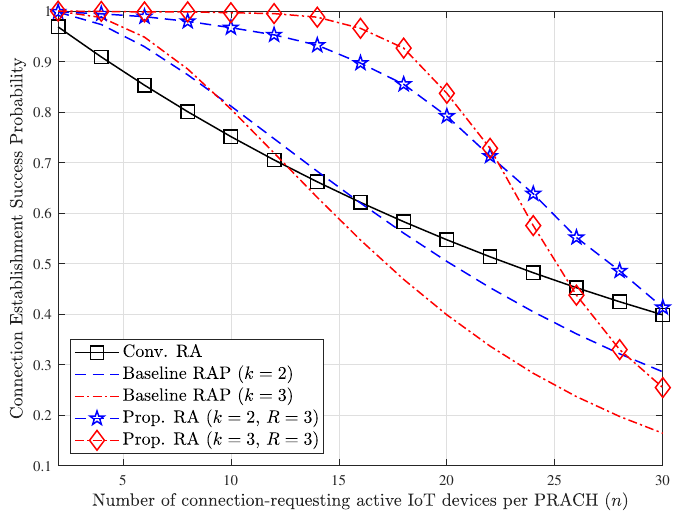
Figure 8. Comparison of connection establishment success probability for varying n when M =